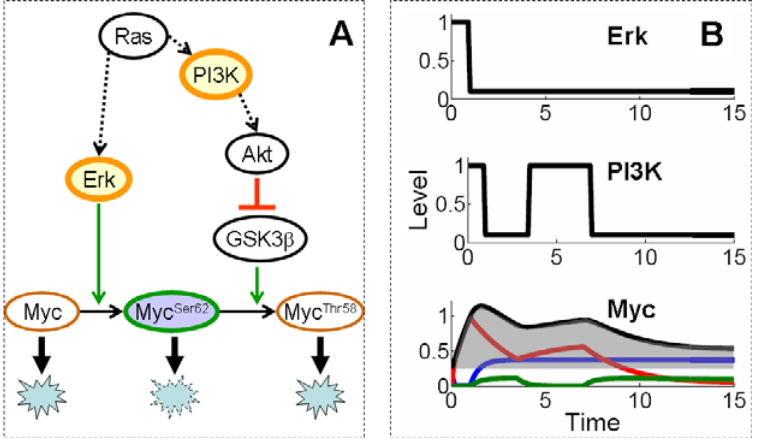
Figure 1. Myc protein stabilization for Myc accumulation. (A) Stimulation with growth factors (GF) leads to activation of Ras and Myc synthesis. Active Ras induces activation of its downstream effector pathways: the MAPK and PI3K pathways. While the synthesized Myc is unstable with short half-life, its stability can be significantly increased via the Ras effector pathways. Active Ras induces Erk that stabilizes Myc by phosphorylation at Ser62. PI3K activation blocks Myc degradation by inhibiting phosphorylation at Thr58 by Gsk3 b . As Ras activity declines, Gsk3 b initiates phosphorylation of Myc at Thr58 and triggers degradation. Phosphorylation at Thr58 requires prior phosphorylation at Ser62, and phosphorylation at Thr58 induces dephosphorylation at Ser62. (B) Activation patterns of Erk and PI3K determine Myc stability pattern. The three forms of Myc are plotted independently. The unmodified Myc (blue line) and Myc Thr58 (green line) accumulate only to a limited level, but stabilized Myc Ser62 level increases via phosphorylation (red line). The total Myc level is the sum of the three forms of Myc (black line) and its dynamics are highly correlated with input signals, Erk, and PI3K. We define the shaded area under the Myc curve as ‘‘potency’’, a measure of Myc accumulation.